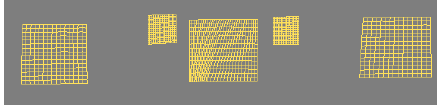
Figure 9. Accuracy assessment of a point cloud generated from raw video frames with reference to TLS data a) in graphical form and b) as a plot